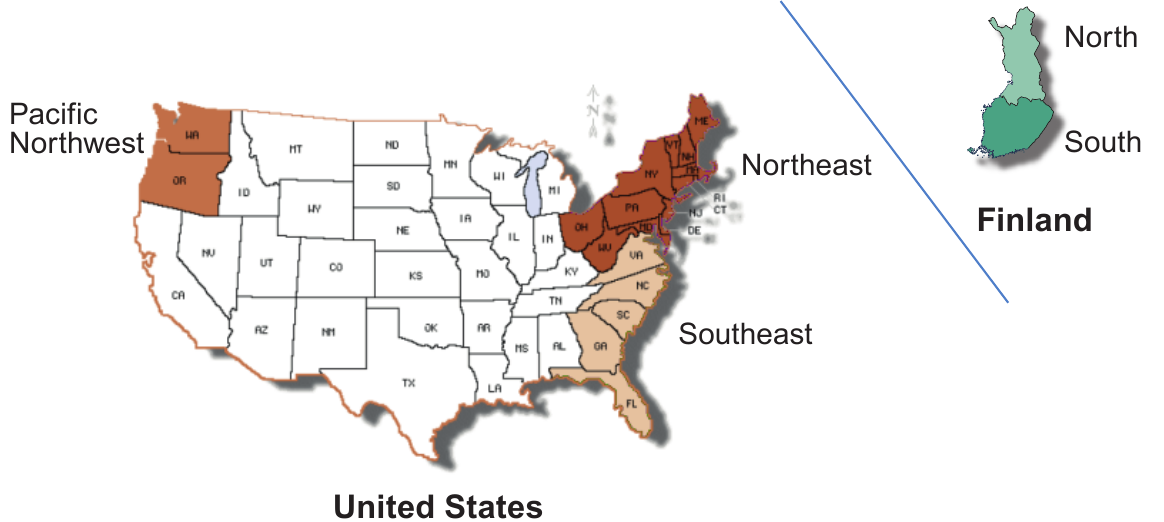
Figure 1. The location of the study regions in the United States and Finland.